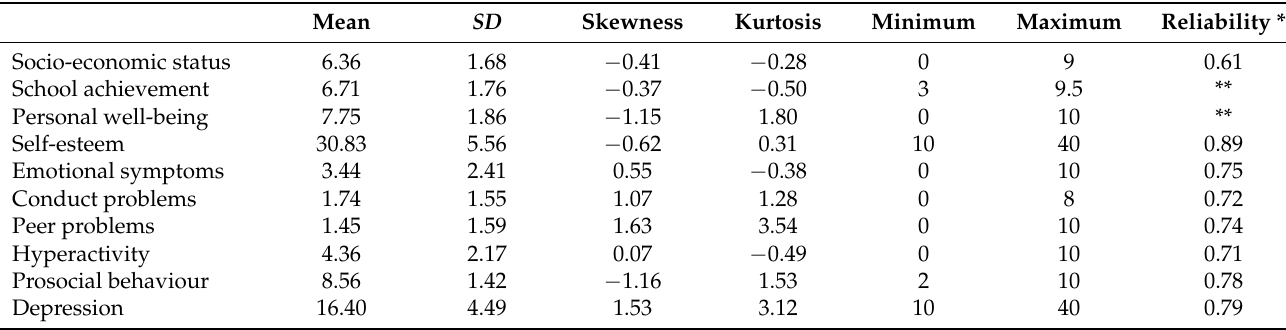
Table 1. Descriptive statistics for the measures